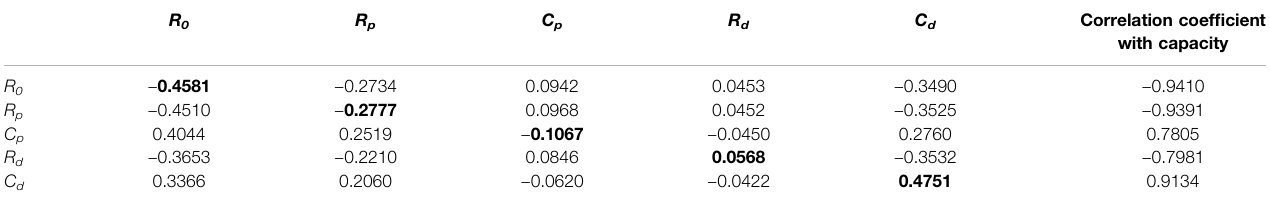
TABLE 4 | Direct path coef fi cient and indirect path coef fi cient of Cell 1 (70% SOC).